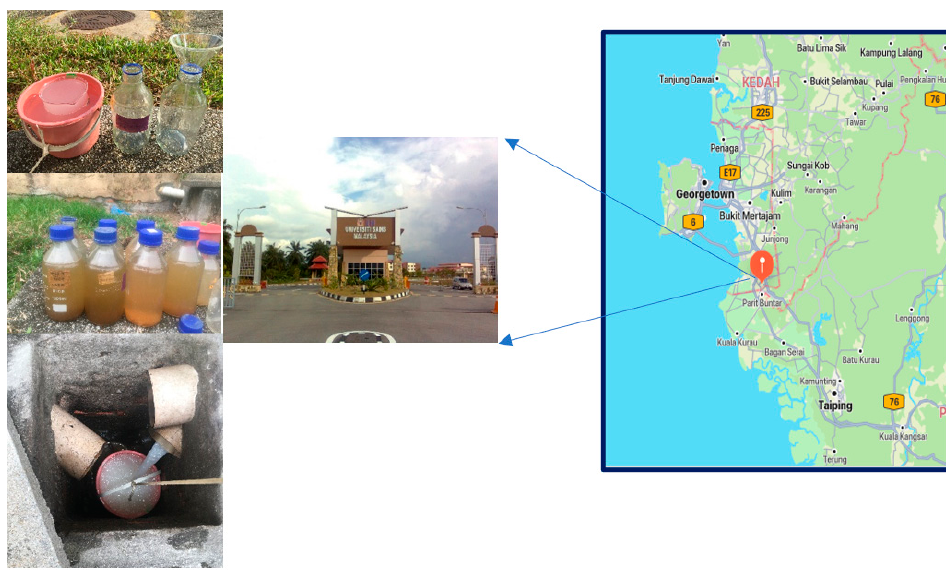
Figure 1. Map of the study area and sample collection. Table 2. Characterisation of the restaurant